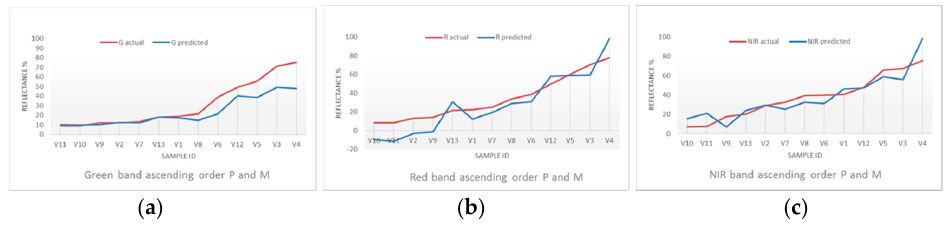
Figure 13. Ascending order M (red line) and P plots for G ( a ); R ( b ) and NIR ( c ) bands from EL2 Spect . The OLS plots of measured (M) regressed against predicted (P) reflectance values per camera waveband are shown in Figure 14 below.